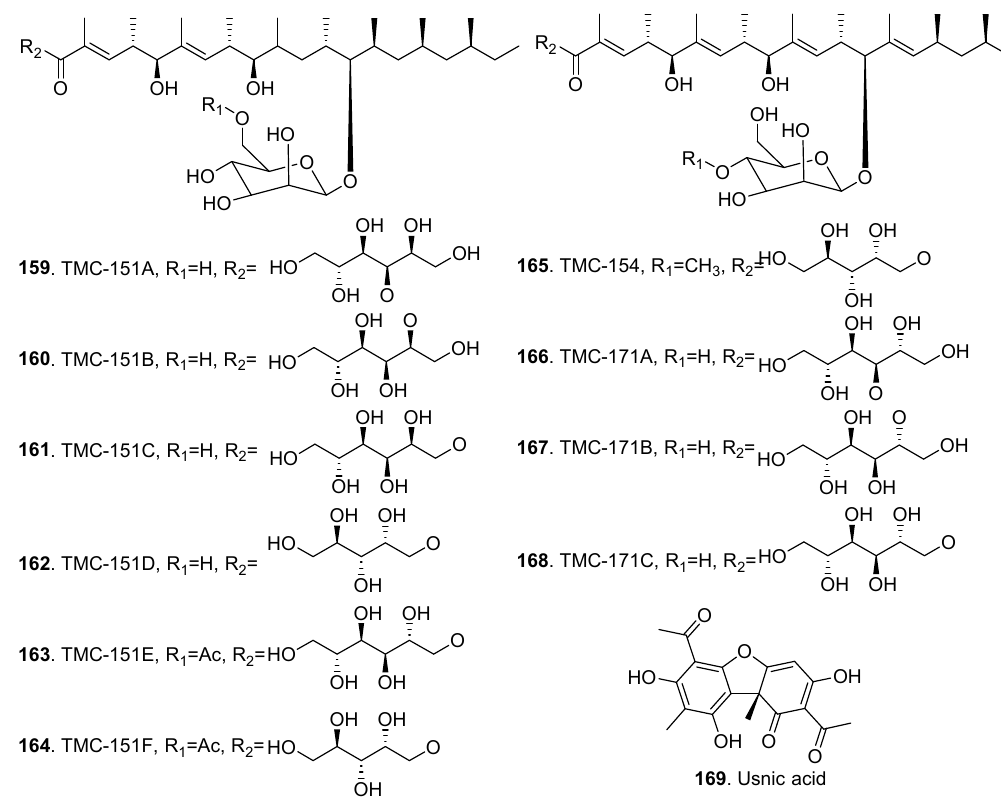
Figure 8. Other polyketides isolated from Clonostachys fungi.